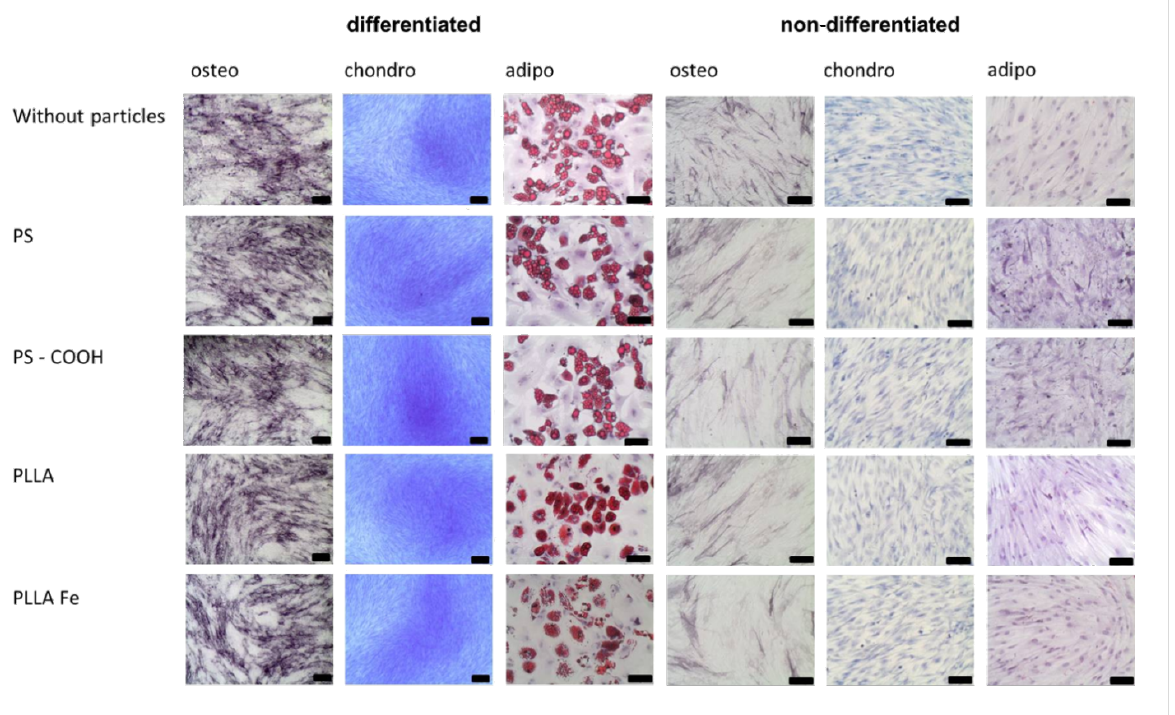
Figure 5: Cytochemical staining to determine the differentiation of hMSCs incubated with different nanoparticles (300 µg/mL nanoparticles, incuba- tion time 24 h, before inducing differentiation). Osteogenic differentiation was demonstrated by alkaline phosphatase activity, chondrogenic differenti- ation by methylene blue staining of the extracellular matrix, and adipogenic differentiation by Oil-Red O staining of the lipid droplets. Samples without particle incubation (without particles) served as controls. The black scale bar represents 200 µm (except for adipo and non-differentiated samples, 100